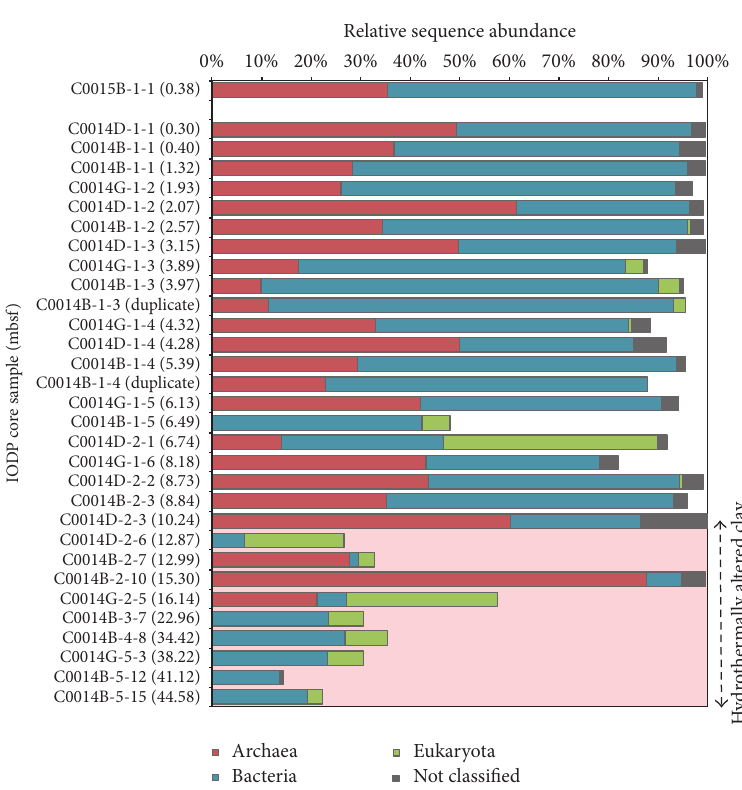
Figure 1: Relative sequence abundance, listed as % across the 𝑥 -axis, of 16S rRNA gene amplicons from Site C0014 sediment samples classified